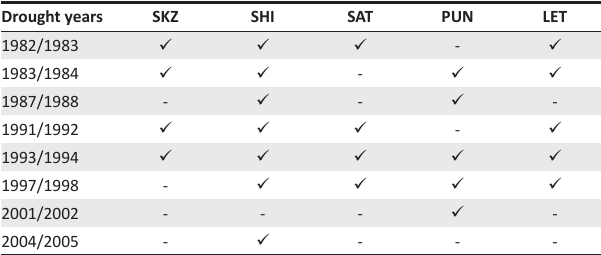
TABLE 2: Major drought comparison.